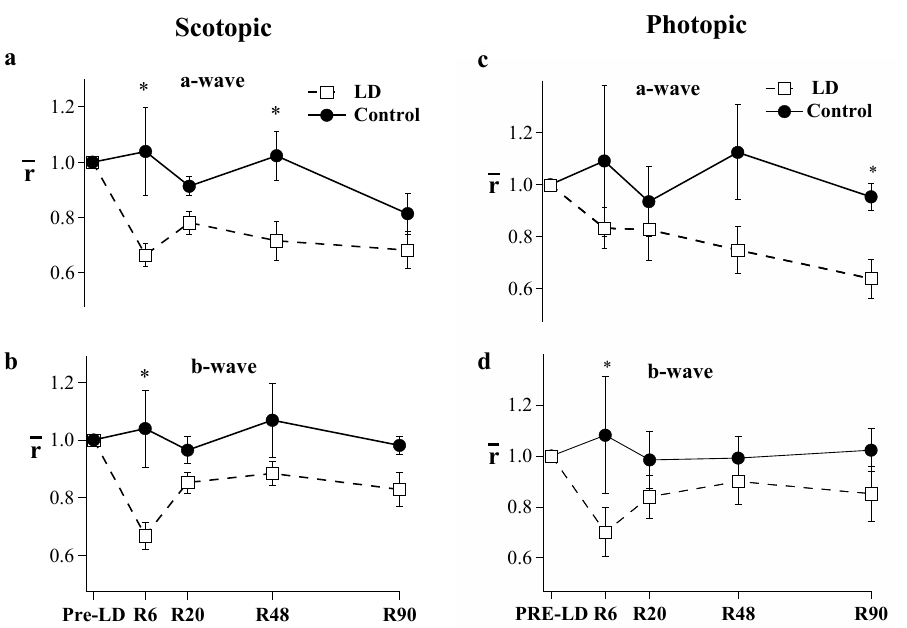
Figure 2. Comparison of the dark ‐ adapted ( a , b ) and light ‐ adapted ( c,d ) flash ERG (Rmax) between light ‐ damaged (open squares, n = 5–10) and control animals (filled circles n = 3–6). Recordings were made before light damage and on recovery day (R) 6, 20, 48, and 90. Each animal’s response was normalized to its pre ‐ light damage value. Error Bars = ± SEM. (* p < 0.05).